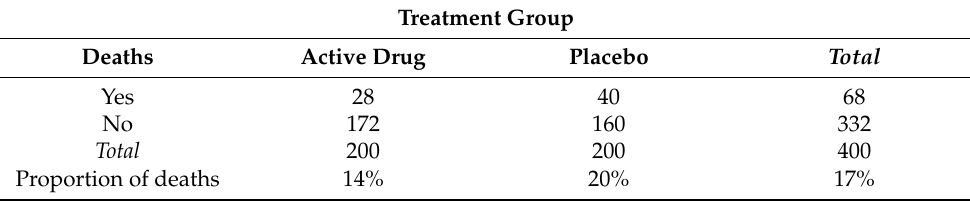
Table 1. Results of the single-center, randomized, double-blind, placebo-controlled trial. Treatment